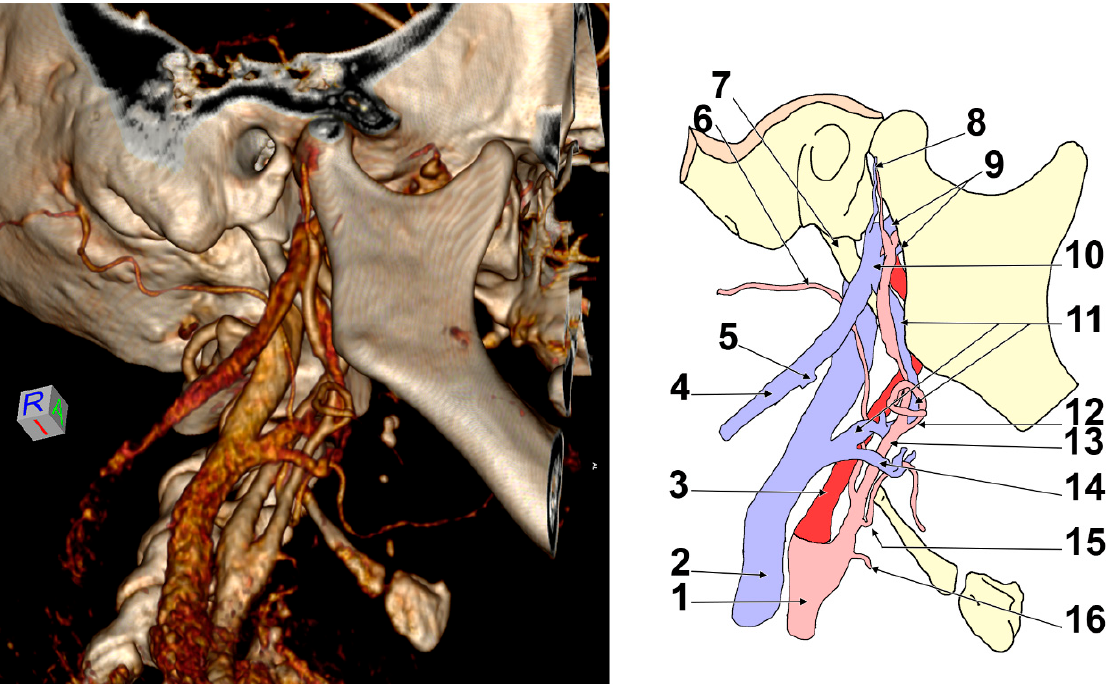
Figure 2. Right infero-lateral view of the retromandibular fossa and carotid triangle. Three-dimensional volume rendering and drawing. 1. Common carotid artery; 2. internal jugular vein; 3. internal carotid artery; 4. external jugular vein; 5. terminal end of the facial vein; 6. occipital artery; 7. styloid process; 8. superficial temporal artery and vein; 9. maxillary veins; 10. retromandibular vein; 11. Launay’s external carotid vein; 12. facial artery; 13. external carotid artery; 14. thyro- lingual venous trunk; 15. lingual artery; 16. superior thyroid artery.